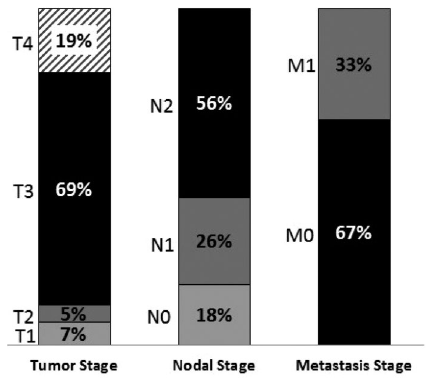
Figure 1. Frequency of tumor staging (T1, T2, T3, and T4), nodal staging (N0, N1, N2) and metastatic staging (M0, M1) of 150